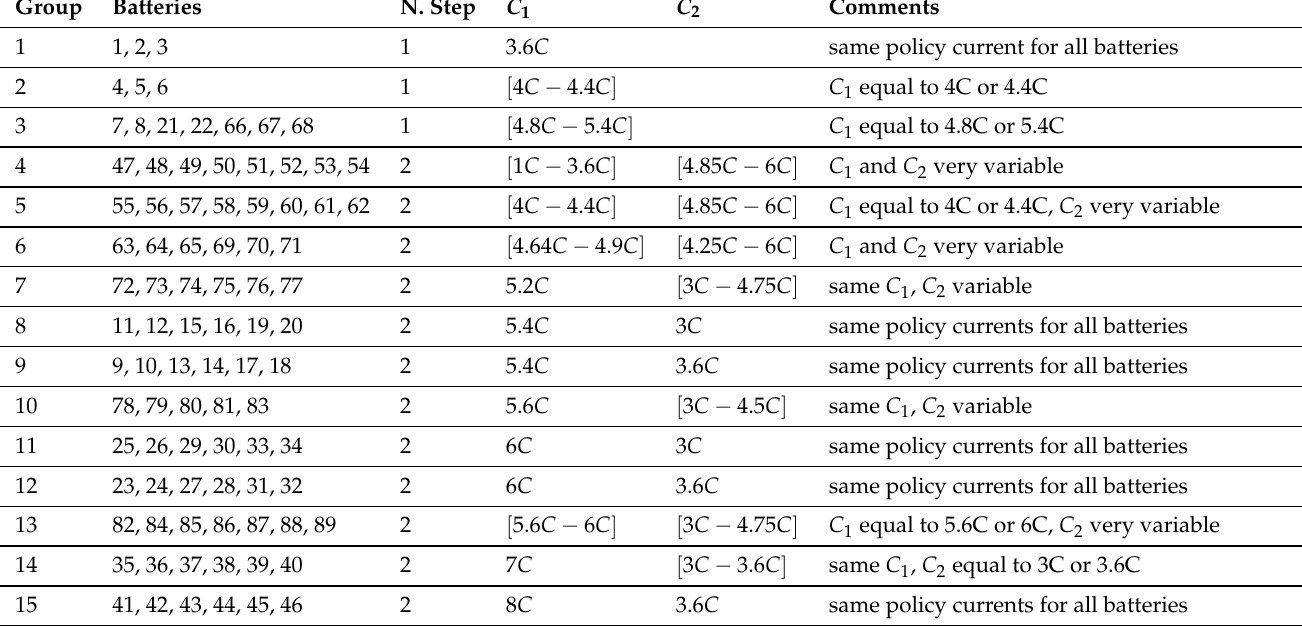
Table 1. Considered batteries groups defined according to fast charging